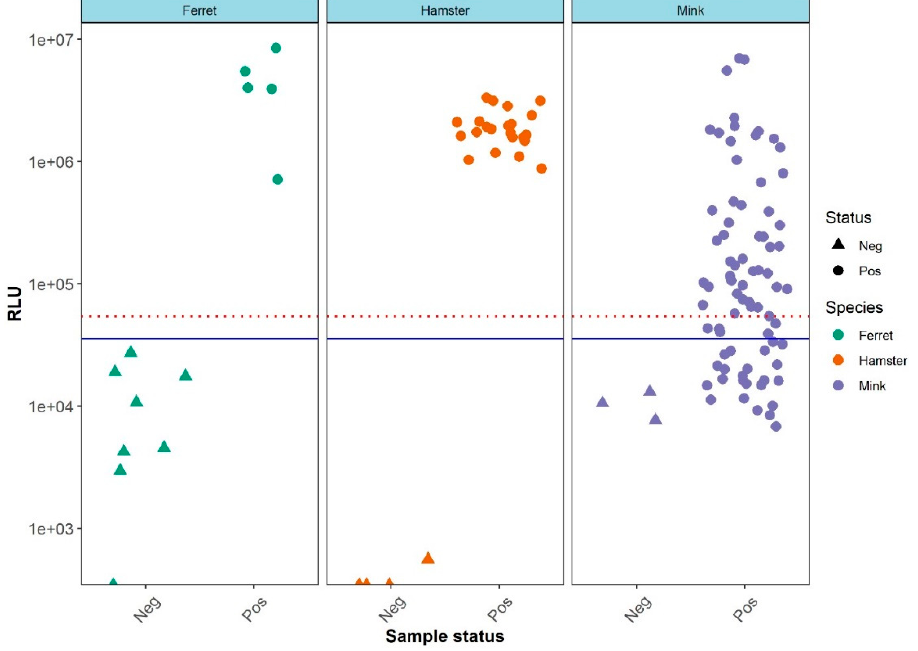
Figure 3. Distribution of the LIPS-N assay RLU values based of the sample’s SARS-CoV-2 antibody neutralization Note that all true negative samples are located below the blue threshold line of mean plus three standard deviations. A threshold line of mean plus five standard deviations (red dotted line) is also included for reference.